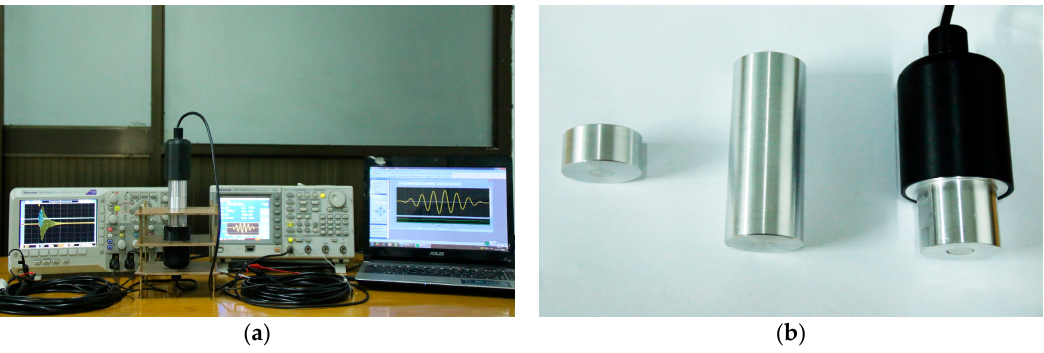
Figure 16. The pitch-catch experimental platform, ( a ) experimental testing; ( b ) Aluminum cylinders and sandwiched piezoelectric ultrasonic transducers.